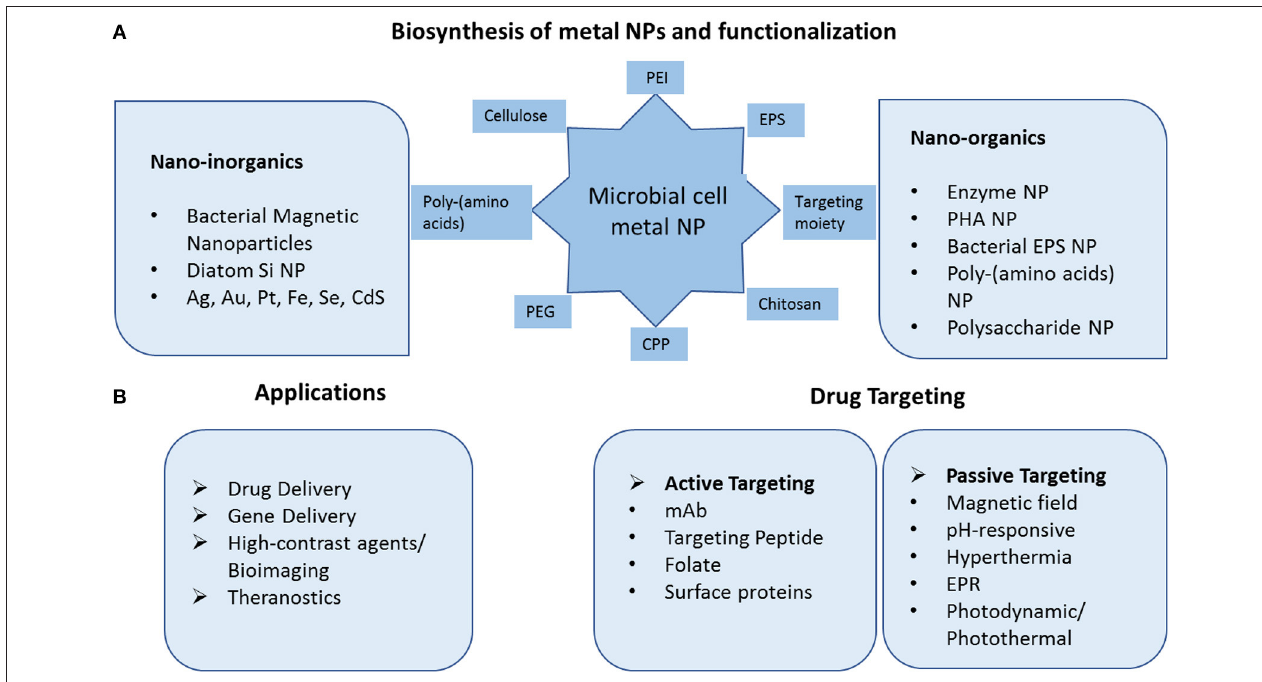
FIGURE 1 | Schematic diagram of microbial fabricated nanosystems and their application in drug delivery and targeting. (A) Biosynthesis of inorganic metal nanoparticles and biopolymeric nanoparticles. The nanoparticles can be functionalized with variety of peptides, polynucleotides, amino acids, targeting moiety. (B) Application of nanoparticles in drug and gene delivery via active and passive mode of targeting and in high quality diagnostic techniques as contrast agents. PEI Polyethyleneimine, EPS ExoPolySaccharides, CPP Cell Penetrating Peptide, PEG Polyethylene Glycol, PHA PolyHydroxyAlkanoates, mAb Monoclonal Antibody, EPR Enhanced Permeability, and